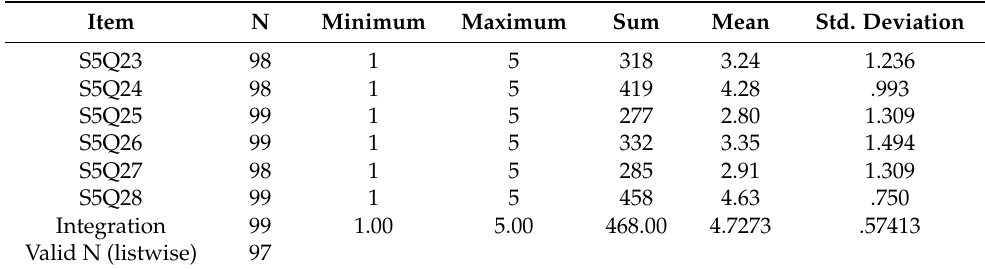
Table 6. Descriptive statistics of perception of Adaptation stage.